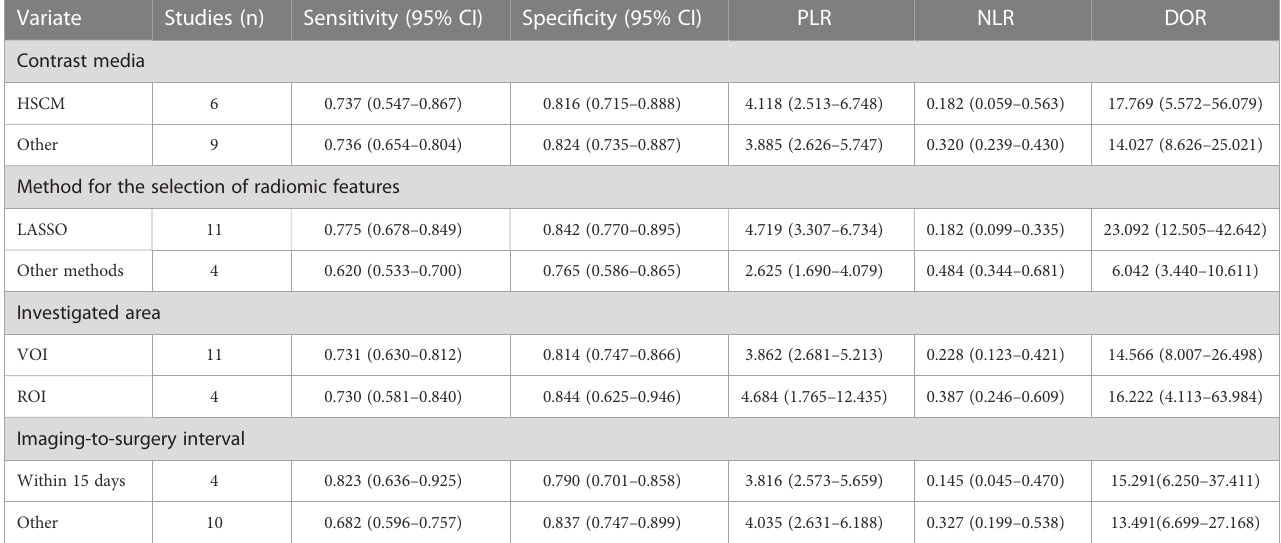
TABLE 4 Results of subgroup analysis.